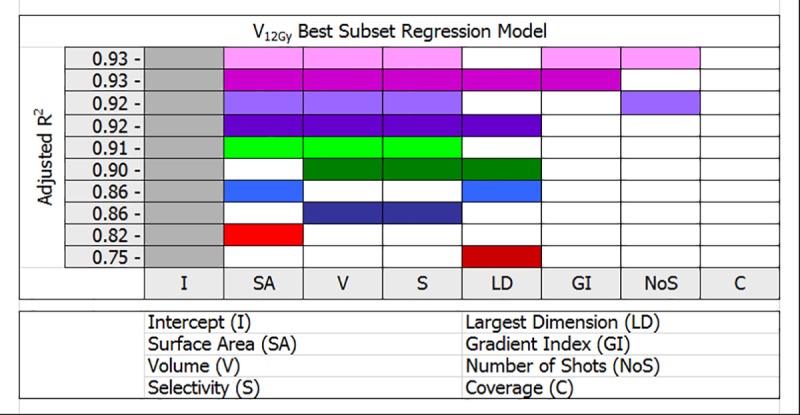
R multivariable V12Gy best subset linear regression analysis for 100 Gamma Knife meningioma patients.The color-coded parts in each row indicate number of variables used to model V12Gy volume. Best two models for a given number of variables are shown.